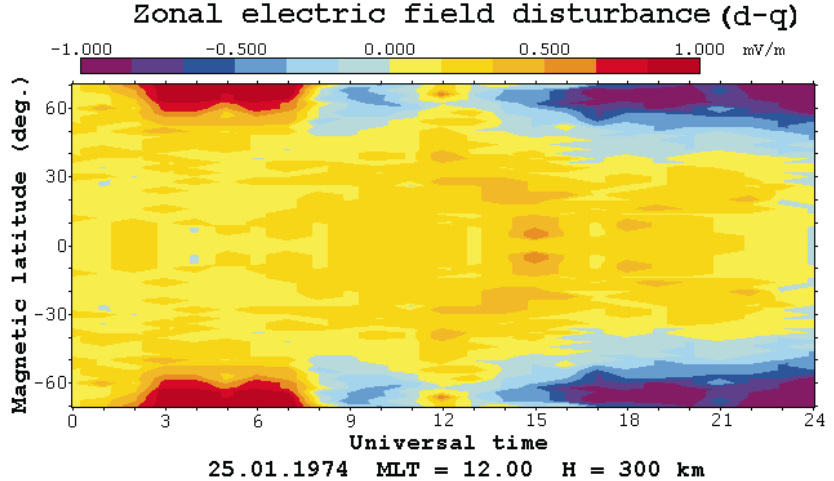
Fig. 9. The storm time evolution of the zonal component of the electric disturbance field (storm minus quiet field values, mV m ) 1 ) for 1200 MLT at an altitude of 300 km. The magnetic latitude range is confined to (cid:139)70 (cid:176) to show mid and low